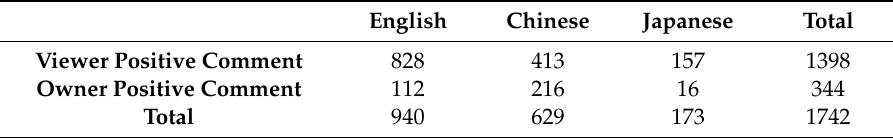
Table 5. Result of positive